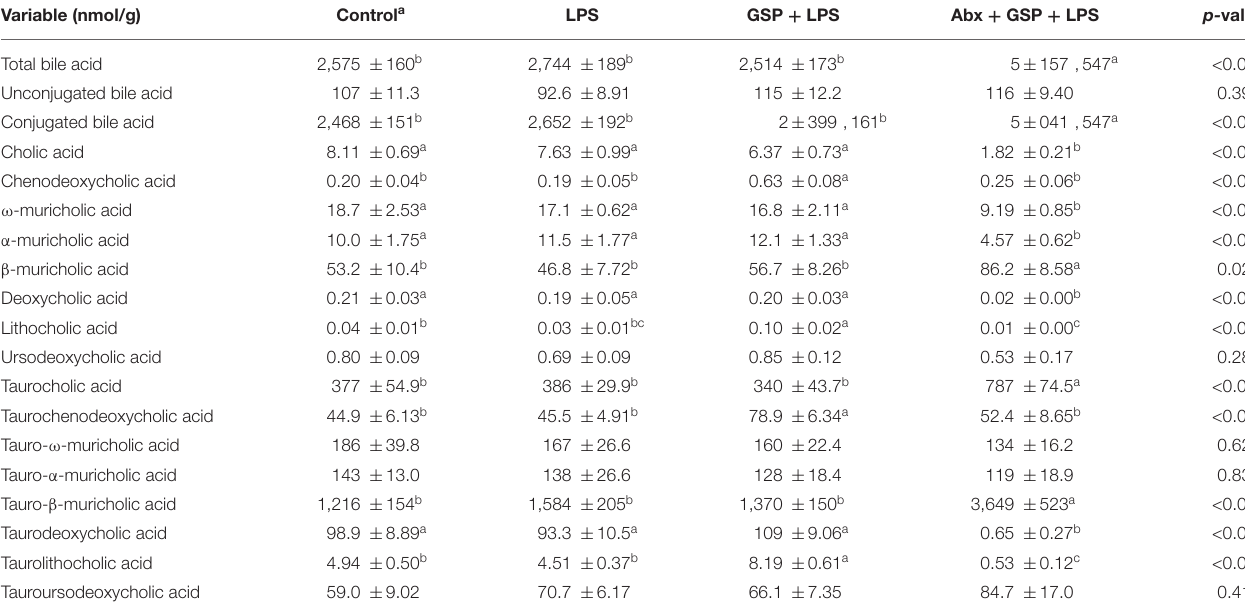
TABLE 1 | Hepatic BA profiles of mice in Experiment